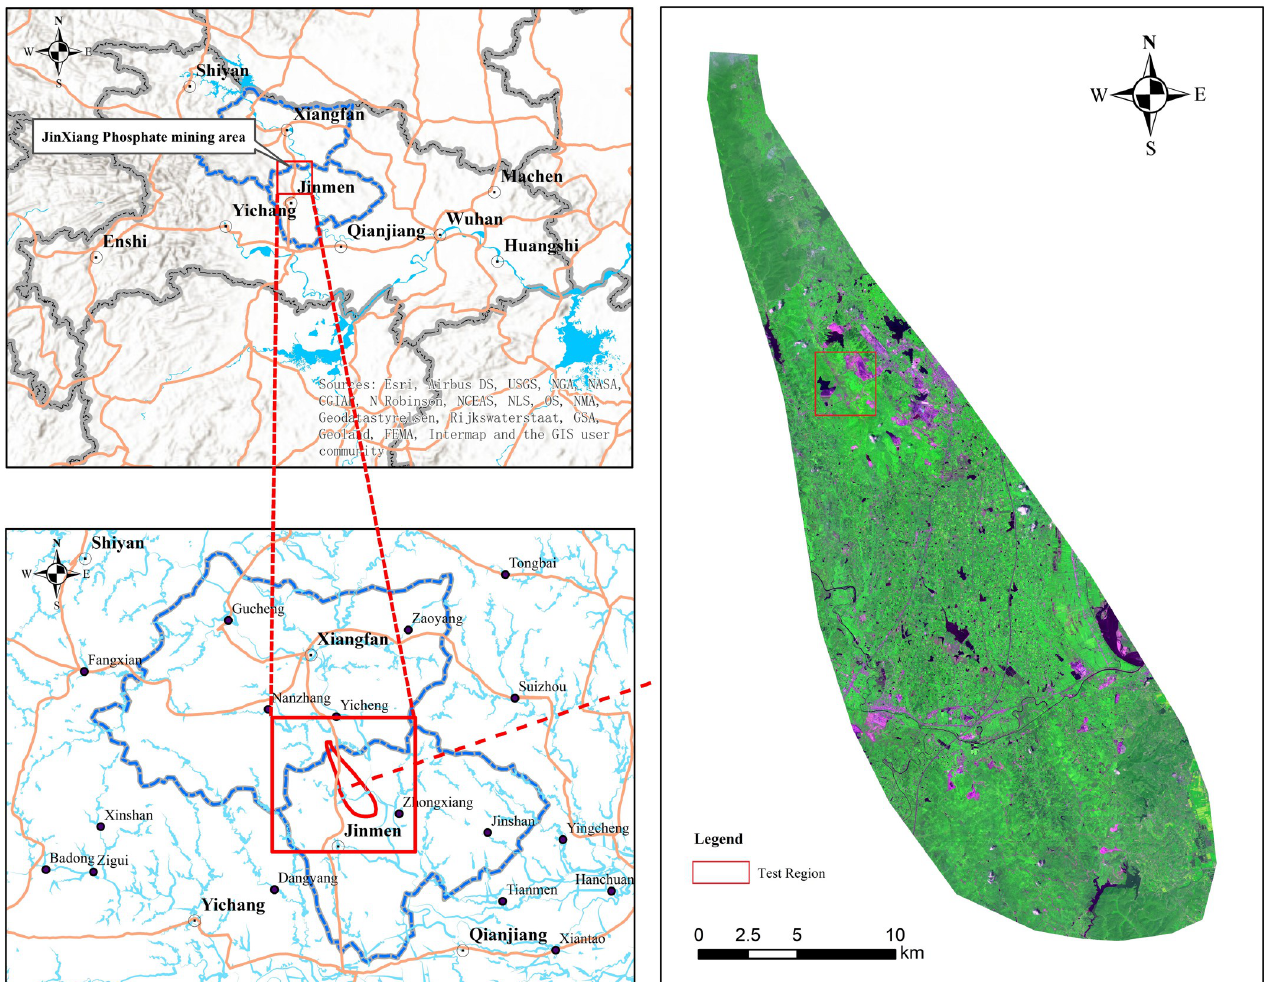
Fig 1. Schematic diagram of the research area of Jingxiang phosphate mine. Republished under a CC BY license, with permission from HBUT, original copyright 2017.